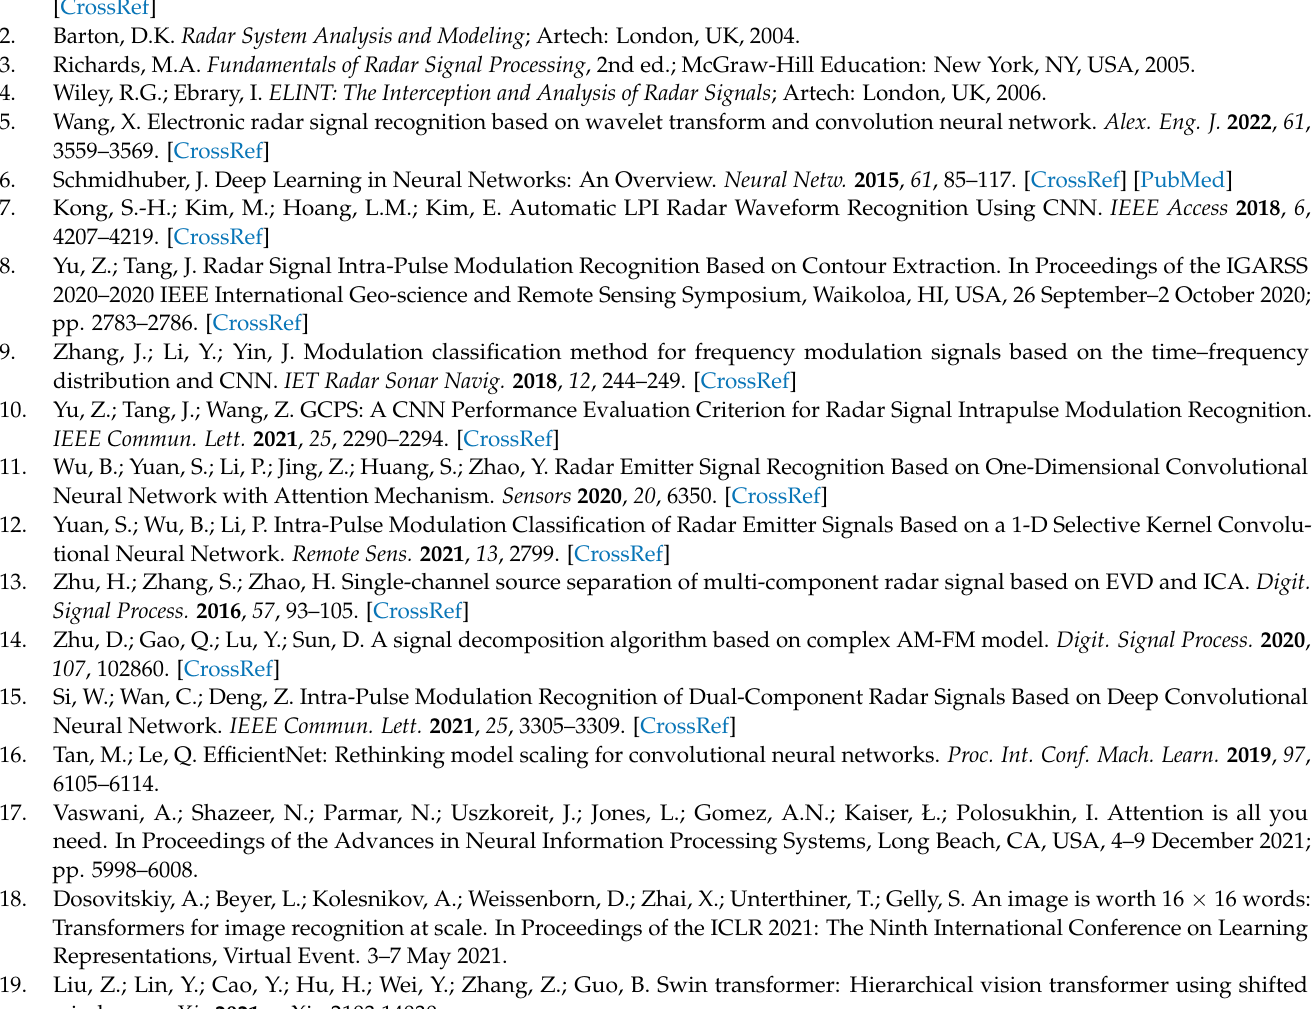
Table A3 indicates that the original architecture of transformer model could not perform well in classifying the intra-pulse modulations, where its accuracy is quite close to that of the CNN-Normal in Section 5.2. Compared with our proposed CNN&Transformer model, we could conclude that the combination of CNN and transformer could improve the performance of model in classifying intra-pulse modulations of radar emitter